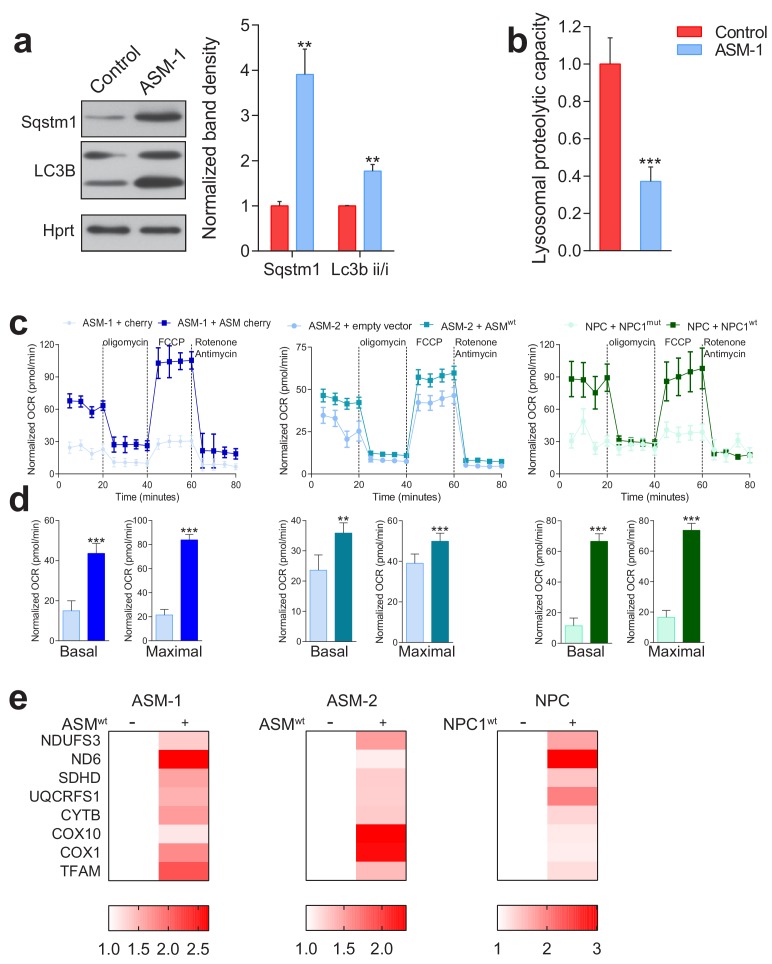
Validation of lysosomal defects in patient fibroblasts and causal relationship of defects to mitochondrial biogenesis and function.The ASM-1 patient cells used in this manuscript have 5% left of acid sphingomyelinase activity, and present the expected signs of lysosomal impairment, specifically (a) decreased autophagic capacity with accumulation of autophagic substrates (p62 also known as Sequestosome 1, Sqstm1) and autophagosomes, as assessed by the autophagosomal marker LC3B-II. Blots are representative of biological triplicates and adjacent plots are depicted as average ± s.e.m., n = 3. T-test p-value **p<0.01 (b) decreased lysosomal proteolytic capacity, as assessed by the rate of DQ-BSA degradation by the lysosomal proteases in whole cells normalized to protein content. Quantification represents mean ± s.e.m., n = 3 (c–e) transfection of all patient lines with the corresponding wildtype protein rescues mitochondrial respiration as assessed by increased OCRs in ASM deficient lines with cherry ASM overexpression and in NPC1 deficient line with NPC1wt overexpression. Quantifications are presented underneath each seahorse profile in panel d) as average ± s.e.m., n = 2 with eight technical replicates per condition. T.test p-value **p<0.01 and ***p<0.001. (e) Mitochondrial gene expression, as assessed by qPCR, is increased in all patient lines following overexpression of corresponding wiltype proteins. The data is presented in a heatmap for n = 3, in which red denotes increased expression in wiltype protein-overexpressing patient lines compared to white, which represents no change relative to the control values.